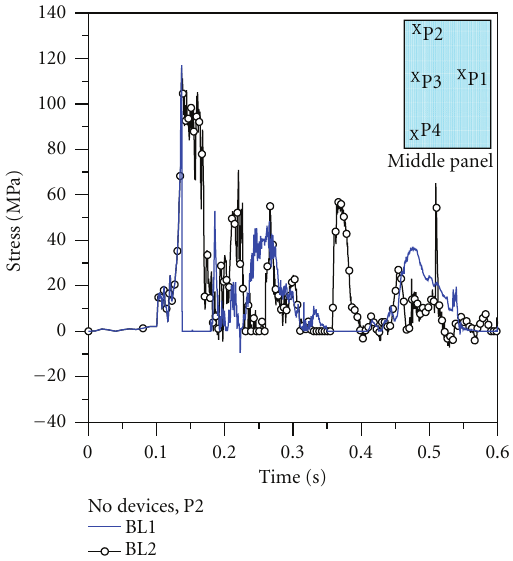
Figure 6: Comparison of maximum tensile stresses at location P2, as a function of time (ABAQUS). No devices. M01 FE-model, BL1 and BL2.